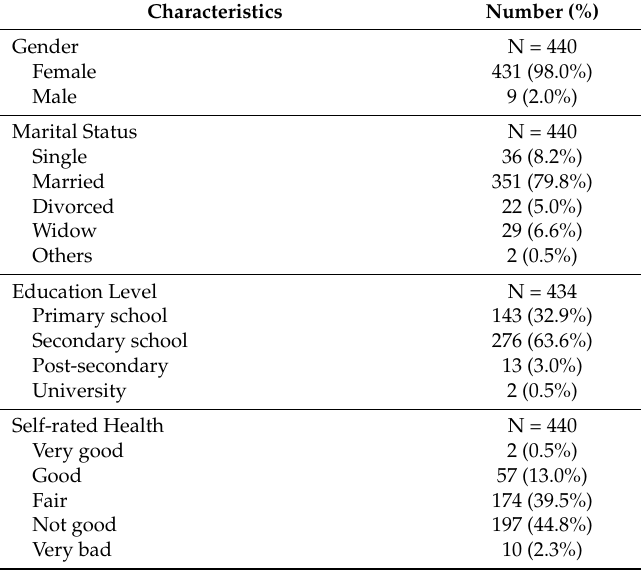
Table 1. Personal and work characteristics of nursing assistants (NAs) (N =